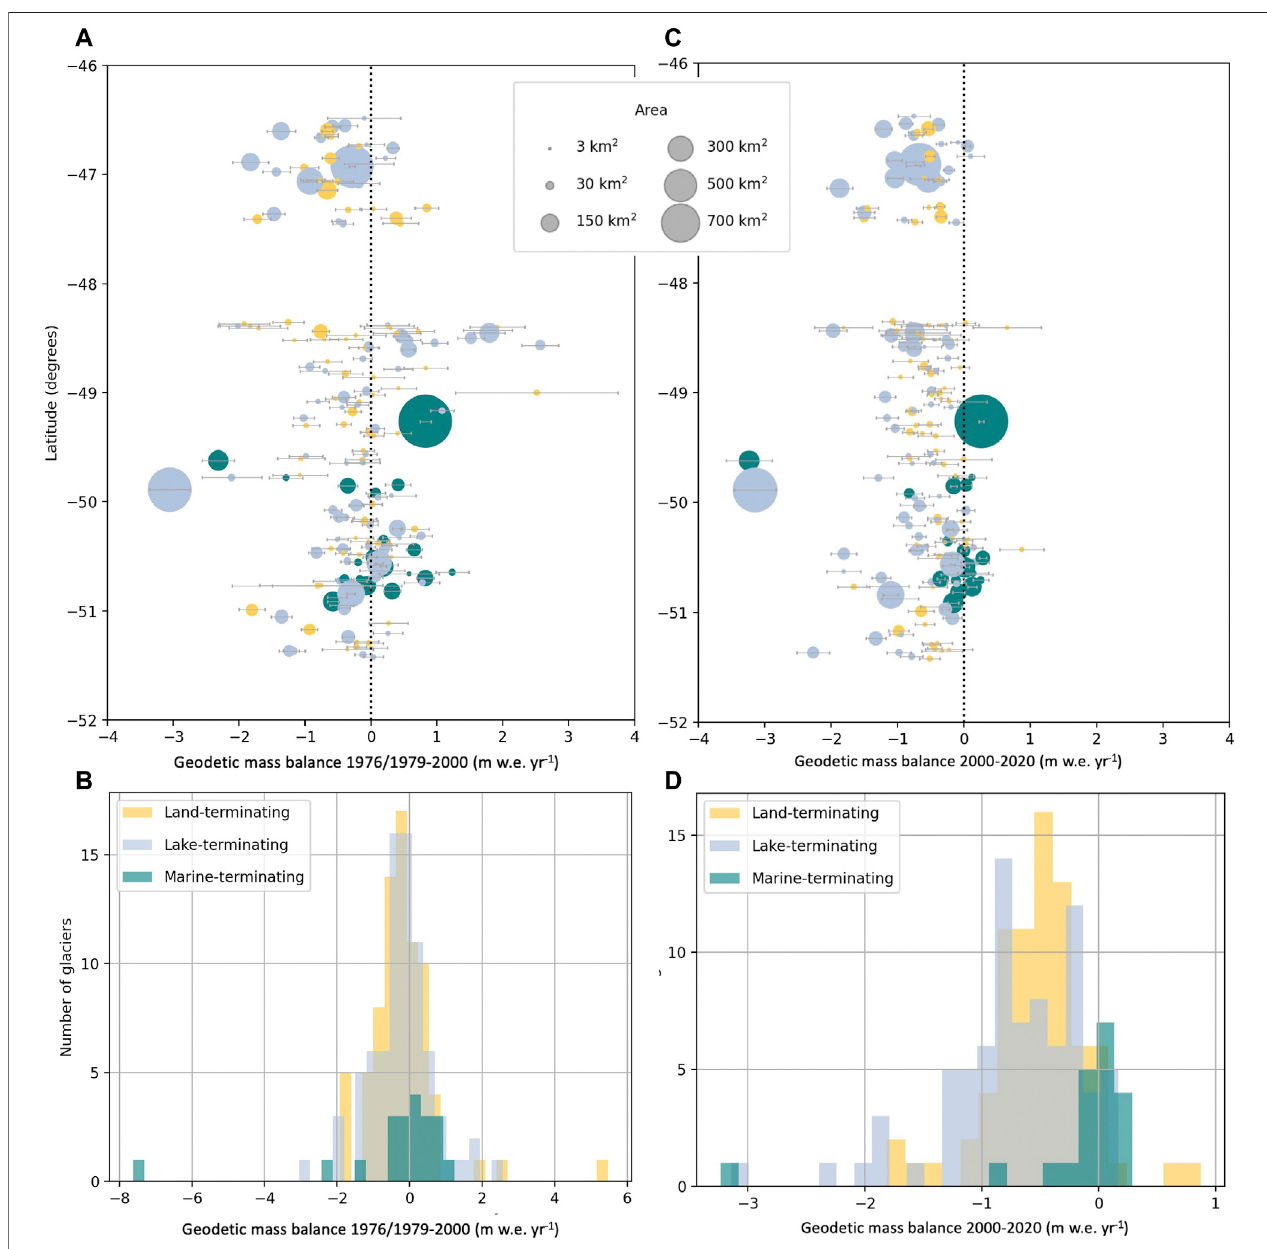
FIGURE 5 | Geodetic mass balance plotted with latitude for (A) the historical time period (1976 – 2000 overlap and 1976/1979 – 2000 overlap in Table 3 ), clipped to − 4 to +4 m w.e. yr − 1 to show the spread around 0 m w.e. yr − 1 ; and (C) the modern time period (2000 – 2020 overlap in Table 3 ). Histograms for (B) 1976/1979 – 2000 and (D) 2000 – 2020 show the distribution of geodetic mass balance according to glacier terminus type. Panel (B) extends the 1976/ 1979 – 2000 results to show all glaciers with data in both time periods.